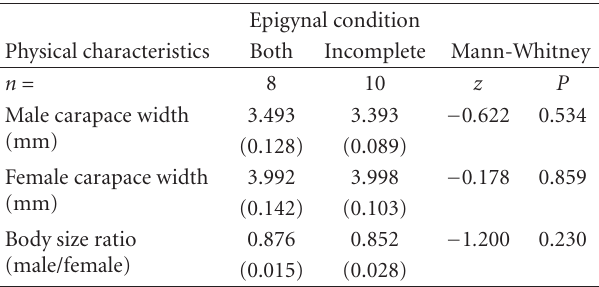
Table 2: Means ( ± SE) of physical characteristics for laboratory pairs of Peucetia viridans who mated ( n = 18) by postmating epigynal condition of females. Epigynal condition was classified as both if the left and right epigynal orifices were completely blocked by plug material, or incomplete if this was not the case. The results of Mann-Whitney U tests for di ff erences between the groups are also shown.